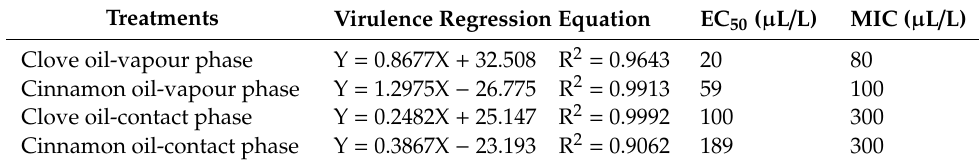
C. gloeosporioides